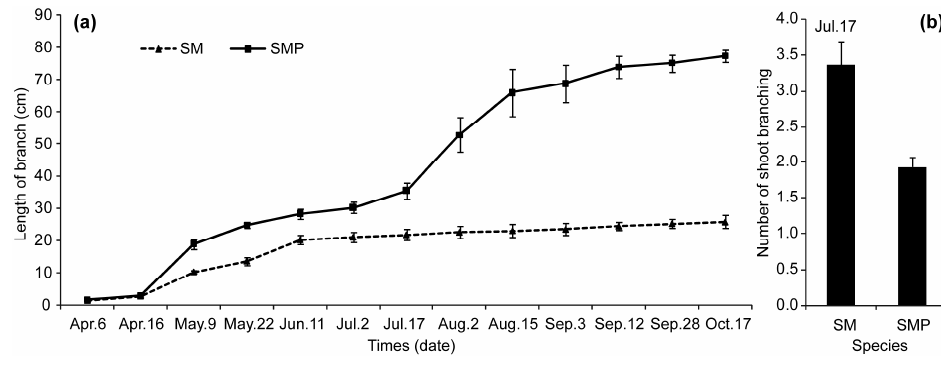
Figure 1. Growth ( a ) and shoot branching numbers ( b ) variation during different developmental stages. SM and SMP represent S. matsudana and S. matsudana var. pseudo-matsudana . Genes 2017 , 8 , 359